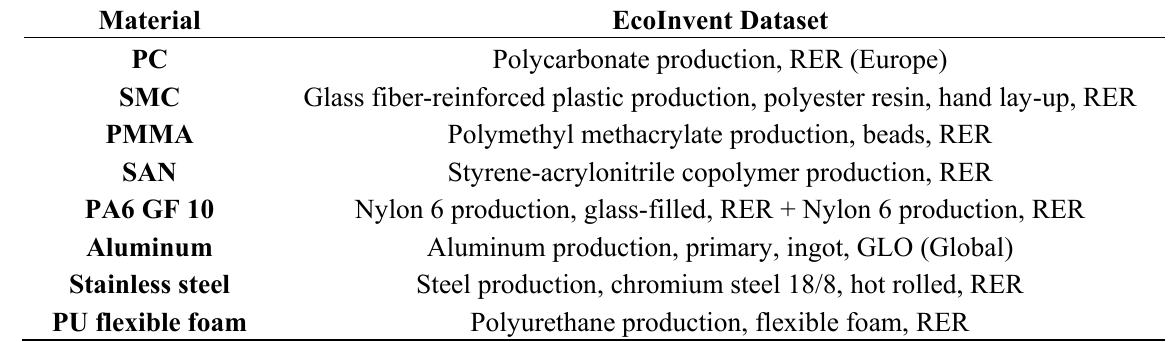
Table 2. Material datasets.